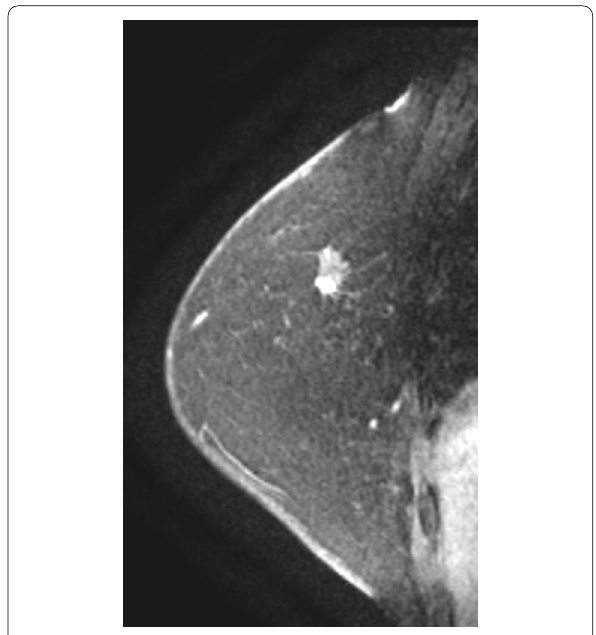
Fig. 3 Contrast-enhanced MRI findings of breast. Spiculated, contrast-enhanced, 12-mm mass in right upper lateral zone.